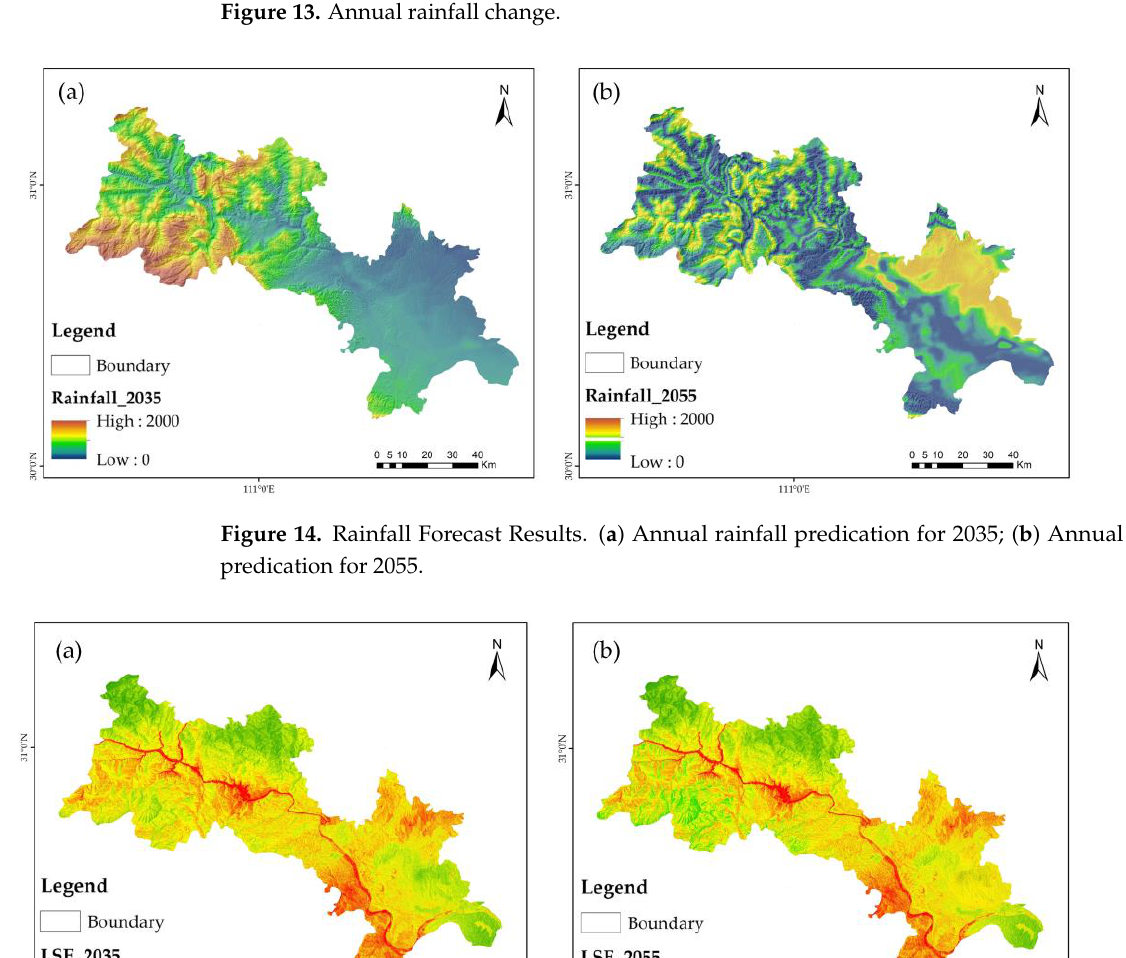
Figure 13. Annual rainfall change.